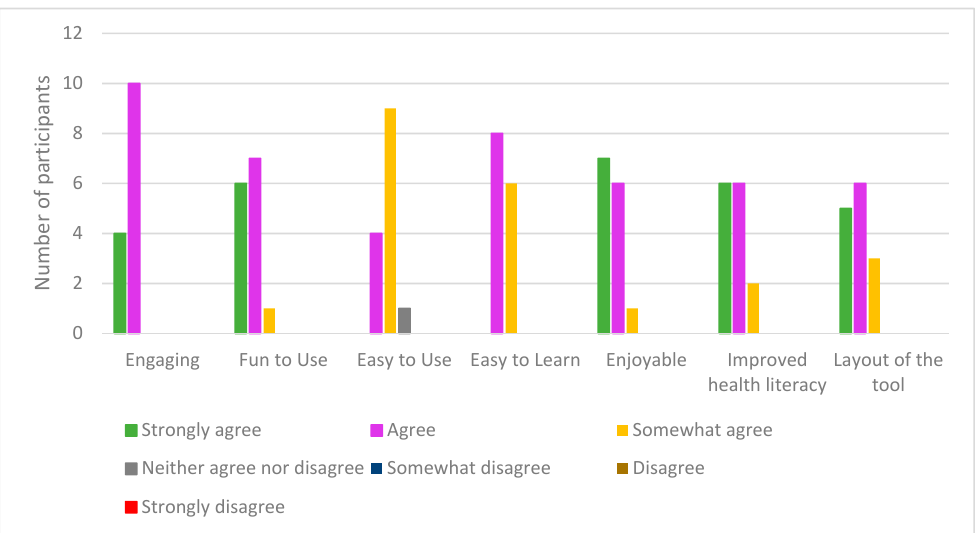
Figure 5. Responses on health literacy experience questionnaire.